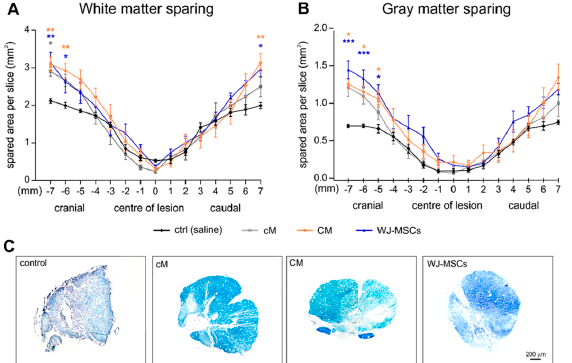
Figure 4. White matter ( A ) and gray matter ( B ) sparing expressed as spared area (mm 2 ) per slice through the lesion area. Asterisks show the statistical significance of a particular treatment when compared to the saline treated control group. The number of animals in the groups is as follows: Saline treated control group n = 7, cM group n = 9, CM group n = 9 and WJ-MSCs group n = 9. ( C ) Representative images of spinal cord cross sections 5 mm cranially from the centre of lesion were stained using cresyl-violet luxol fast